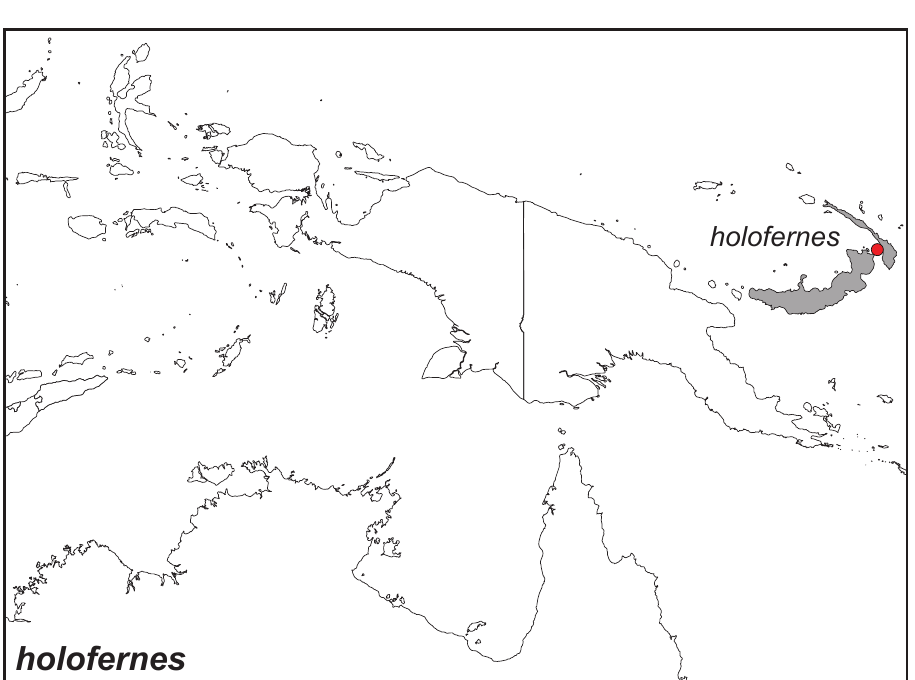
Figure 71. Distribution map of Elymnias hicetas .